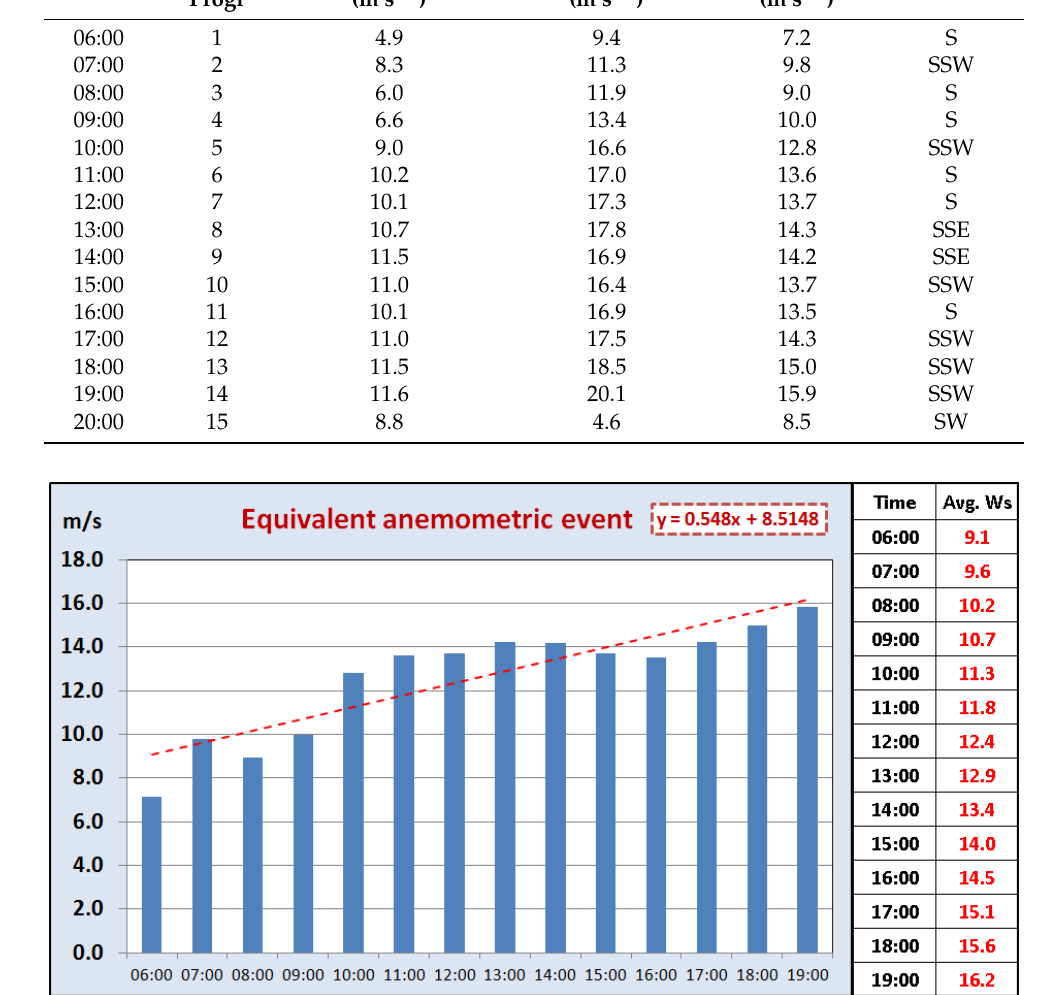
Figure 13. Hourly average anemometric values (Capo Posillipo and ISPRA-Port of Naples weather stations), with linear interpolation line (red values on the right). Wind direction changes are less than 30°; hence, for simplicity, wave heights and periods are computed along a single (mean) direction.